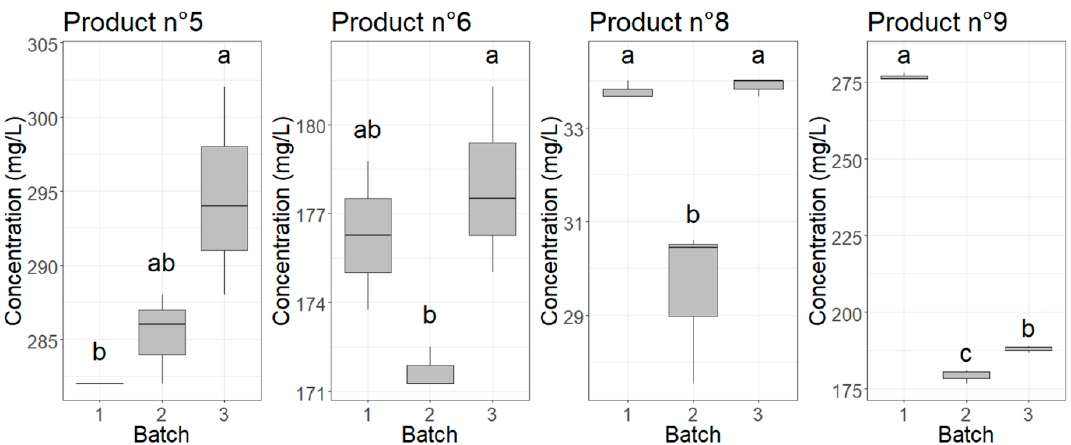
Figure 6. Boxplots showing the variation in measured concentration for the products from which different batches were analyzed. Different letters above the boxes point to significant differences ( p -value < 0.05) between batches according to a Tukey test.